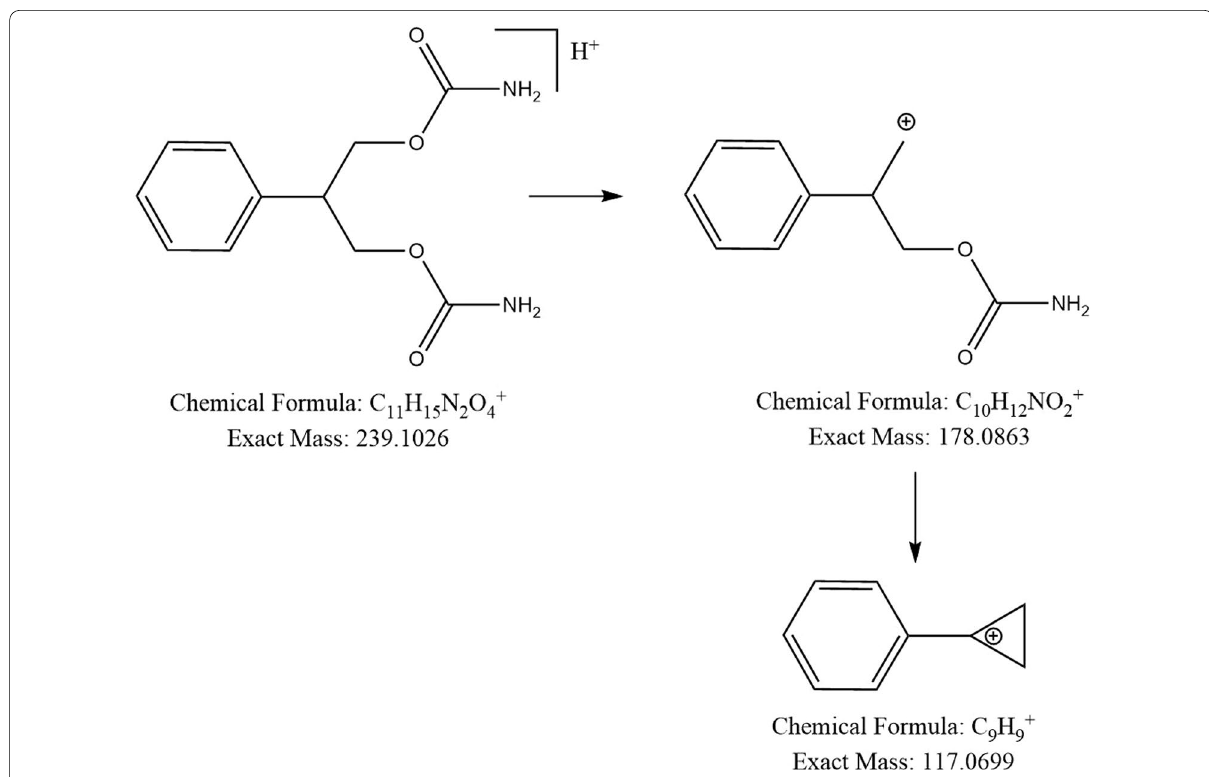
Fig.7 Fragmentation pathway for the